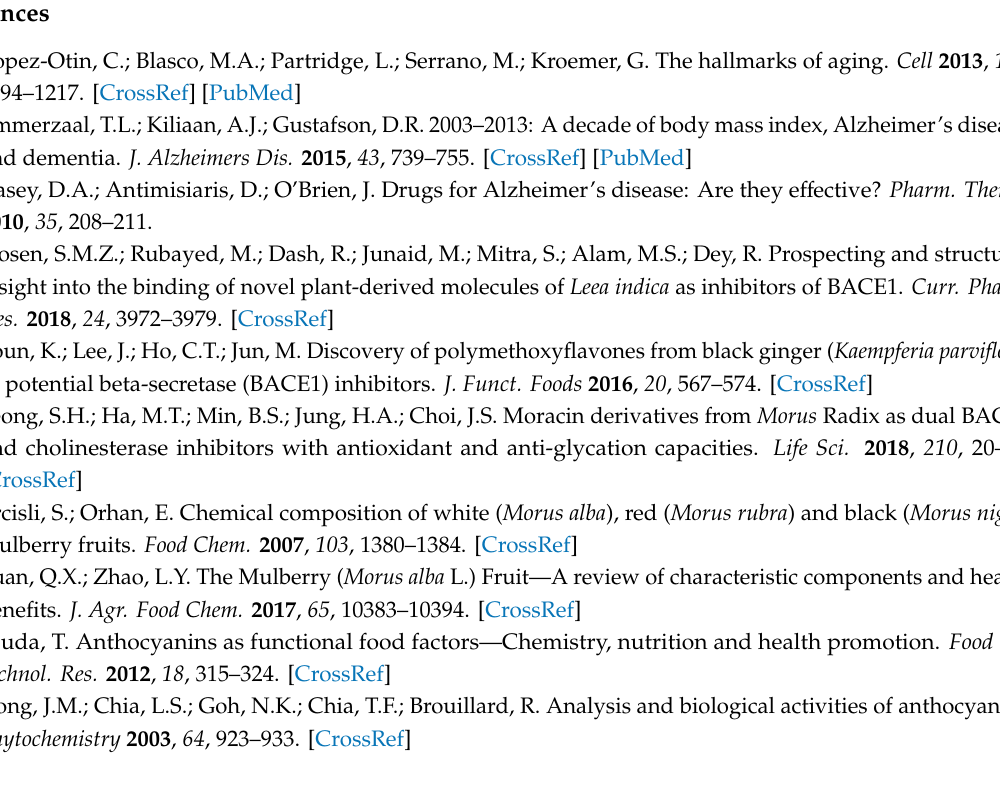
Supplementary Materials: Supplementary Table S1: Images of twenty-seven cultivars, sample codes, and collectors of Morus fruit samples used in this experiment. Supplementary Table S2: Color (where L describes darkness ( − ) to lightness ( + ), a describes green ( − ) to red ( + ) colors, and b describes indigo ( − ) to yellow ( + ) colors) and the percentage (%) of moisture content of fresh and freeze-dried Morus fruit samples. Supplementary Figure S1: High-performance liquid chromatography (HPLC) chromatograms of (A.) cyanidin chloride standard, and anthocyanidin analyses of Morus fruit extracts including (B.) Morus ‘Krua’, (C.) Morus ‘Jak’, (D.) Morus ‘Pai’, (E.) Morus ‘Pai-Ubon’, (F.) Morus ‘Poe’, (G.) Morus ‘Mae Luke On’, (H.) Morus ‘Som’, (I.) Morus ‘Som Yai’, (J.) Morus ‘Sida’, (K.) Morus ‘Kun Pai’, (L.) Morus ‘Nakhon Ratchasima 60’, (M.) Morus ‘Buri Ram 51’, (N.) Morus ‘Buri Ram 60’, (O.) Morus ‘Si Sa Ket 33’, (P.) Morus ‘Number 44’, (Q.) Morus sp. code SKSM 820281, (R.) Morus sp. code SKSM 14-13-20, (S.) Morus sp. code SKSM 040691, (T.) Morus sp. code SKSM 810191’, (U.) Morus sp. code SKSM 810391, (V.) Morus sp. code SRCM 9124-12, (W.) Morus sp. code SRCM 9801-465, (X.) Morus sp. code SRCM 9801-535, (Y.) Morus sp. code SRCM 9801-833, (Z.) Morus sp. code SRCM 9806-271, (AA.) Morus sp. code SRCM 9806-287, and (AB.) Morus sp. code SRCM 9809-34. The retention times ( R t ) of cyanidin chloride in Morus fruit extracts were also indicated. Supplementary Figure S2: High-performance liquid chromatography (HPLC) chromatograms of (A.) kuromanin and keracyanin standards, and anthocyanin analyses of Morus fruit extracts including (B.) Morus ‘Krua’, (C.) Morus ‘Jak’, (D.) Morus ‘Pai’, (E.) Morus ‘Pai-Ubon’, (F.) Morus ‘Poe’, (G.) Morus ‘Mae Luke On’, (H.) Morus ‘Som’, (I.) Morus ‘Som Yai’, (J.) Morus ‘Sida’, (K.) Morus ‘Kun Pai’, (L.) Morus ‘Nakhon Ratchasima 60’, (M.) Morus ‘Buri Ram 51’, (N.) Morus ‘Buri Ram 60’, (O.) Morus ‘Si Sa Ket 33’, (P.) Morus ‘Number 44’, (Q.) Morus sp. code SKSM 820281, (R.) Morus sp. code SKSM 14-13-20, (S.) Morus sp. code SKSM 040691, (T.) Morus sp. code SKSM 810191’, (U.) Morus sp. code SKSM 810391, (V.) Morus sp. code SRCM 9124-12, (W.) Morus sp. code SRCM 9801-465, (X.) Morus sp. code SRCM 9801-535, (Y.) Morus sp. code SRCM 9801-833, (Z.) Morus sp. code SRCM 9806-271, (AA.) Morus sp. code SRCM 9806-287, and (AB.) Morus sp. code SRCM 9809-34. The retention times ( R t ) of kuromanin and keracyanin in Morus fruit extracts were also